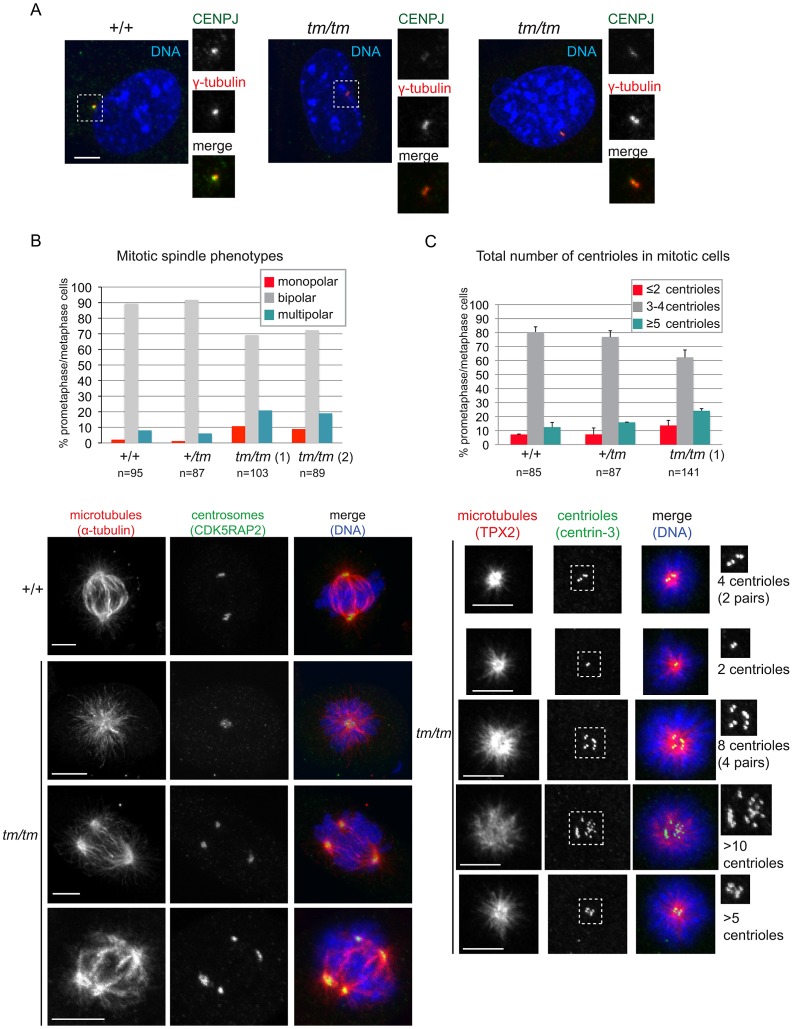
Centrosome and mitotic spindle abnormalities are elevated in Cenpj-deficient cells.A. Images show examples of Cenpj staining in centrosomes of Cenpj
+/+ and Cenpjtm/tm mouse embryonic fibroblasts (MEFs). Cells were stained with antibodies against Cenpj (green in merge) and the centrosomal protein γ-tubulin (red in merge). Framed areas are shown at higher magnification. B. Graph shows mitotic spindle phenotypes in MEFs derived from Cenpj
+/+, Cenpj
+/tm and two independent Cenpjtm/tm embryos (littermates, +/+ MEFs passage 4, +/tm and tm/tm MEFs passage 3): tm/tm (1) and tm/tm (2). Number of mitotic cells scored are shown for each genotype. Examples for monopolar and multipolar spindle are shown. Note cell on bottom panels forming a bipolar spindle by clustering supernumerary centrosomes. Cells were stained with antibodies against α-tubulin (green in merge) and the centrosomal protein, Cdk5RAP2 (red in merge). C. Graph shows centriole numbers in mitotic MEFs of indicated genotypes (littermates, +/+ MEFs passage 4, +/tm and tm/tm MEFs passage 3). Cells were arrested in mitosis with monastrol that caused monopolar spindle formation and facilitated visualization of centrioles. Note that mitotic cells should normally contain a total of 4 centrioles, but even in wild-type cells we occasionally detect 3 centrioles probably due to insufficient spatial resolution, so 3 or 4 centrioles were considered a single class. Data were collected from two independent experiments; bars show mean ±SD, number of mitotic cells scored are shown for each genotype. Images below depict examples for cells with different centriole numbers (top cell with 4 centrioles is normal, all other cells have too few or too many centrioles). Cells were stained with antibodies against the microtubule-binding protein Tpx2 (green in merge) and the centriolar protein, centrin-3 (red in merge). Framed areas are shown at higher magnification. Scale bars = 5 µm.